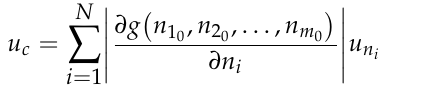
Figure 5. The worst-case scenario provides a maximum heading error that can be computed through the vectors shown here.